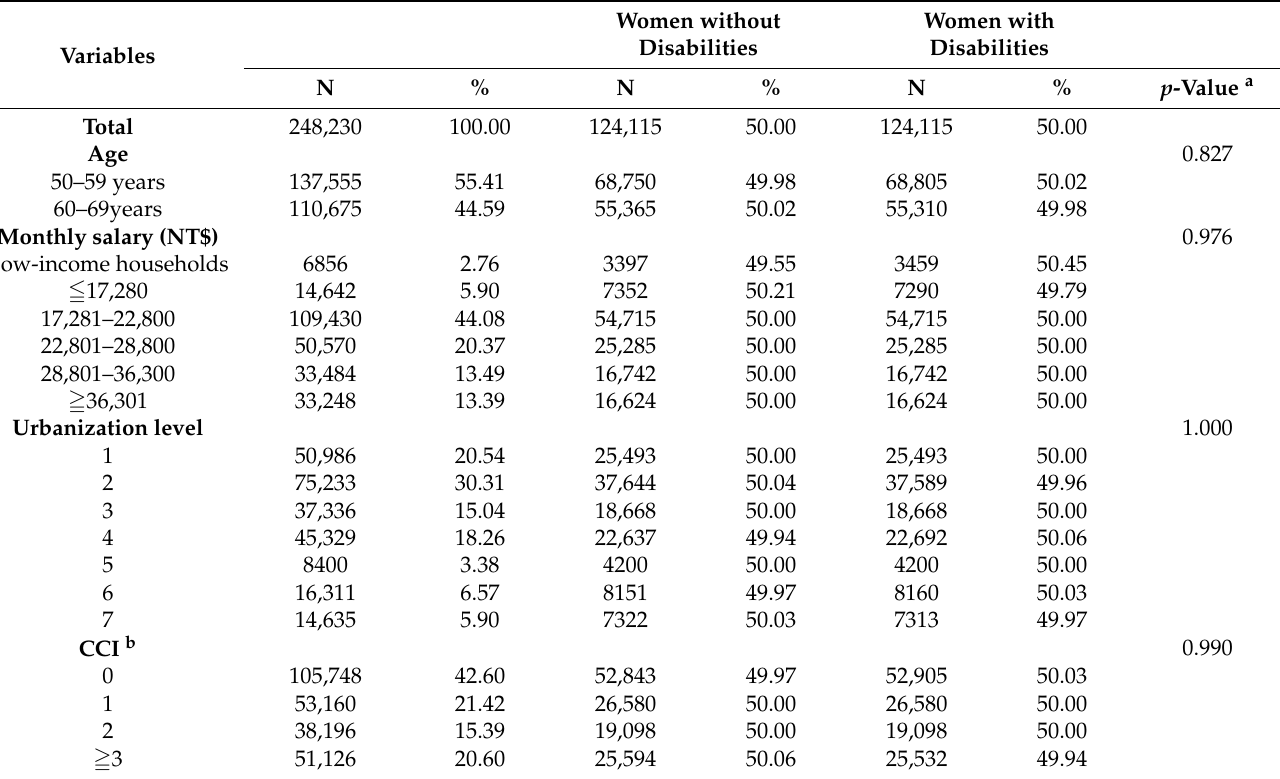
Table 1. The distribution in characteristics of women with disabilities and those without disabilities who meet the criteria for breast cancer screening after